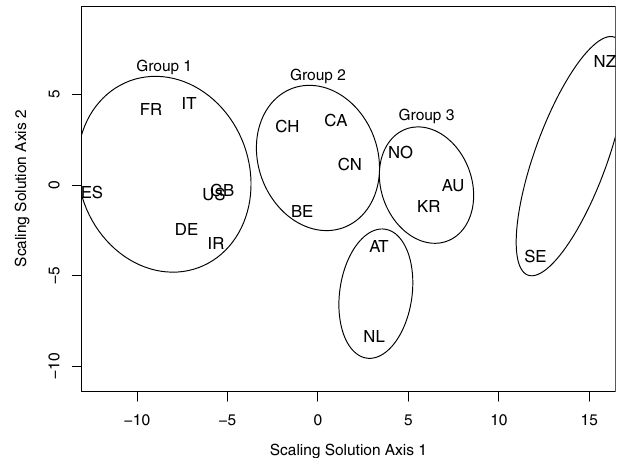
Figure 4. Multidimensional scaling solution of dissimilarity matrix generated by Euclidean distances calculated between two spectral estimates for each pair of countries. Countries’ position denoted by their two character ISO 3166-1 standard abbreviation. The ellipses group together countries that are clustered using the robust cluster stability method 16 . AT = Austria, AU = Australia, BE = Belgium, CA = Canada, CH = Switzerland, CN = China, DE = Germany, ES = Spain, FR = France, GB = United Kingdom, IR = Iran, IT = Italy, KR = South Korea, NL = Netherlands, NZ = New Zealand, NO = Norway, SE = Sweden, US = USA.